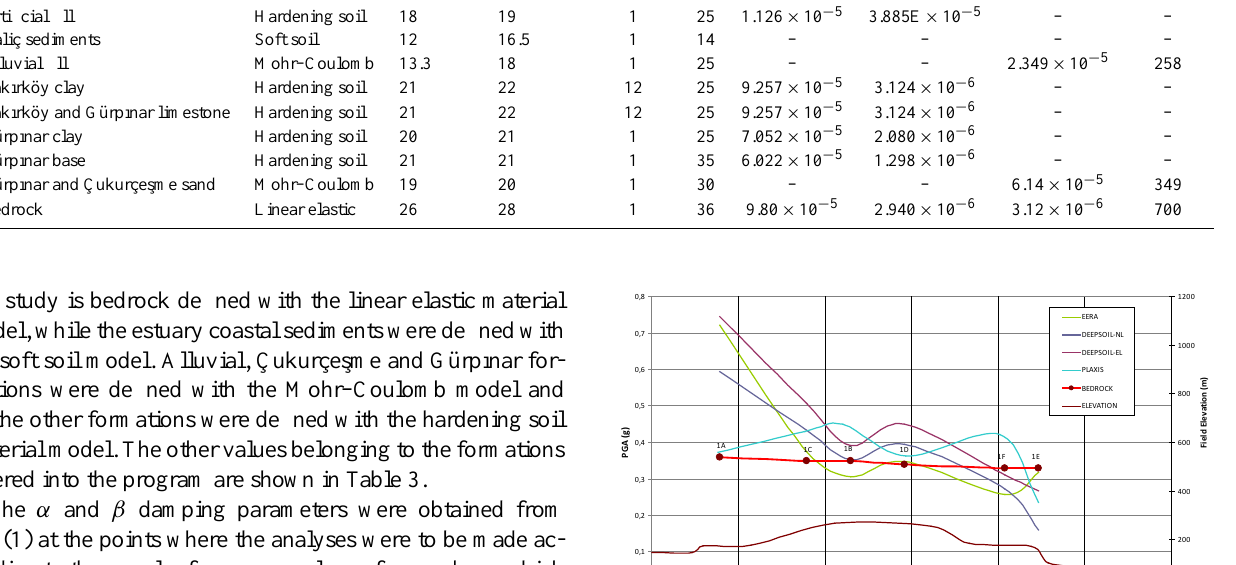
Table 3. The material parameters in used Plaxis for all formations. Formations Material model γ dry γ saturated analyses were evaluated with and within each other and the correlation between them was